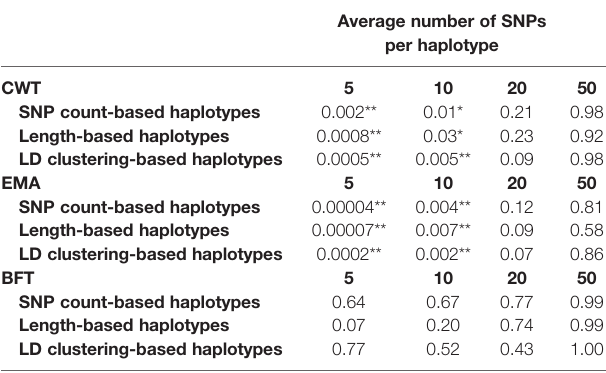
TABLE 3 | P-values of paired t-tests comparing prediction accuracies using individual SNPs and haplotypes de fi ned by different methods and sizes.